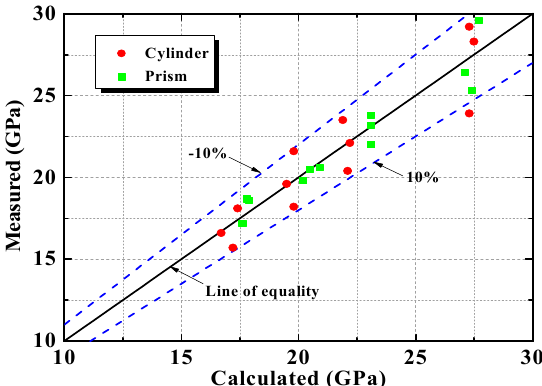
Figure 12. Calculated and measured E *,300,CC .